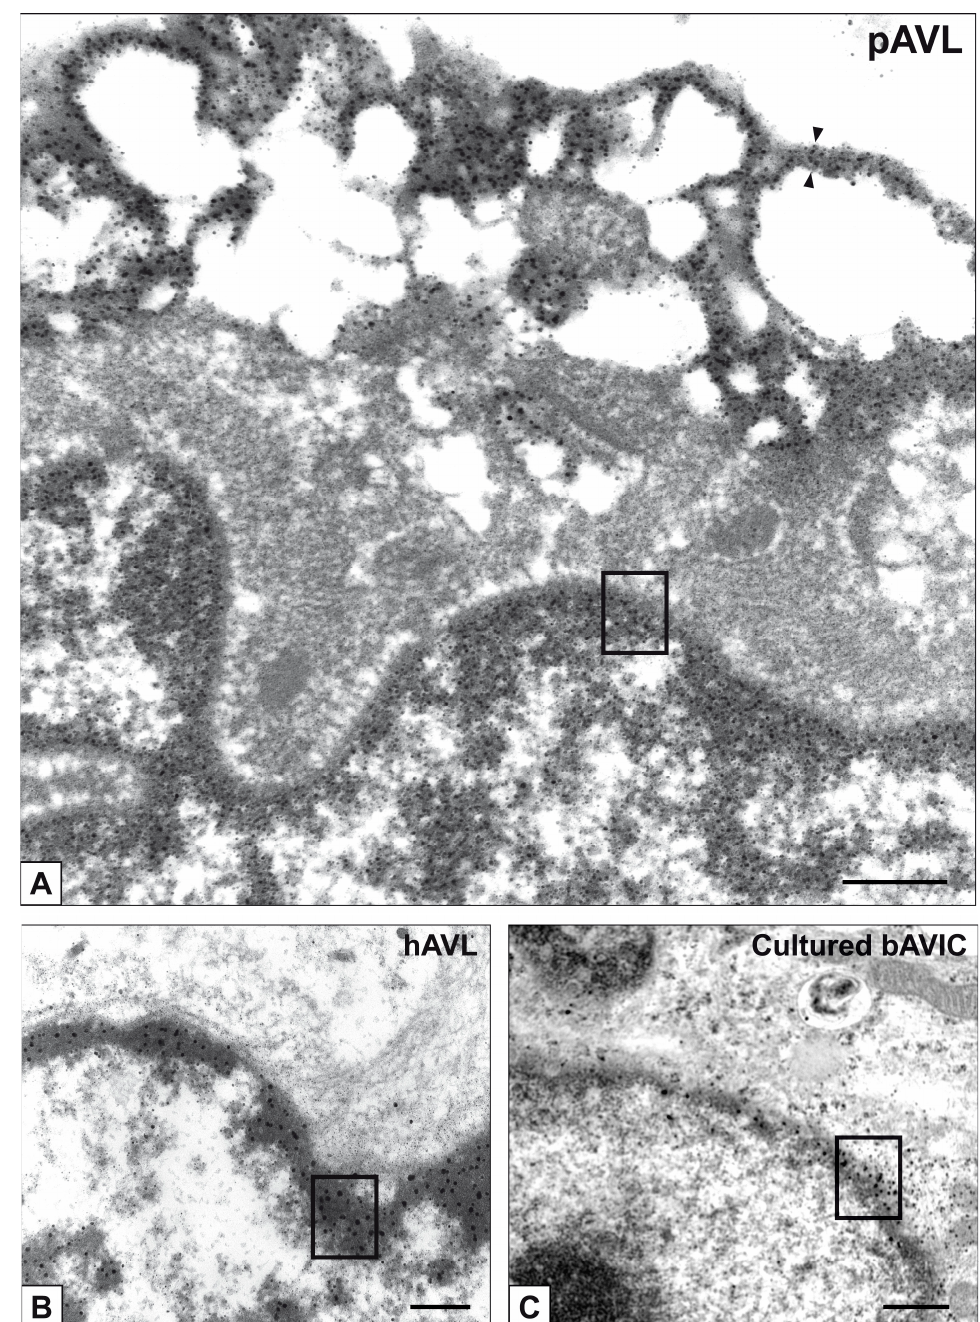
Figure 8. Post-embedding von Kossa staining of nuclear chromatin in mineralizing AVICs. Major silver particle precipitation onto nuclear heterochromatin (rectangular boxes) in mineralizing AVICs from ( A ) 28-day-long subdermally implanted pAVLs, with the largest silver particles being distributed along peripheral PPLs (counterposed arrowheads), ( B ) stenotic hAVLs, and ( C ) pro-calcific cultures. Bar: 0.25 μ m.